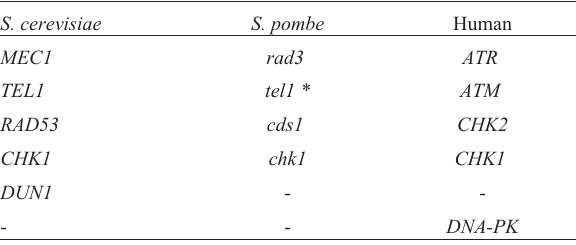
Table 1 - DDR kinases homologs in yeast and human.